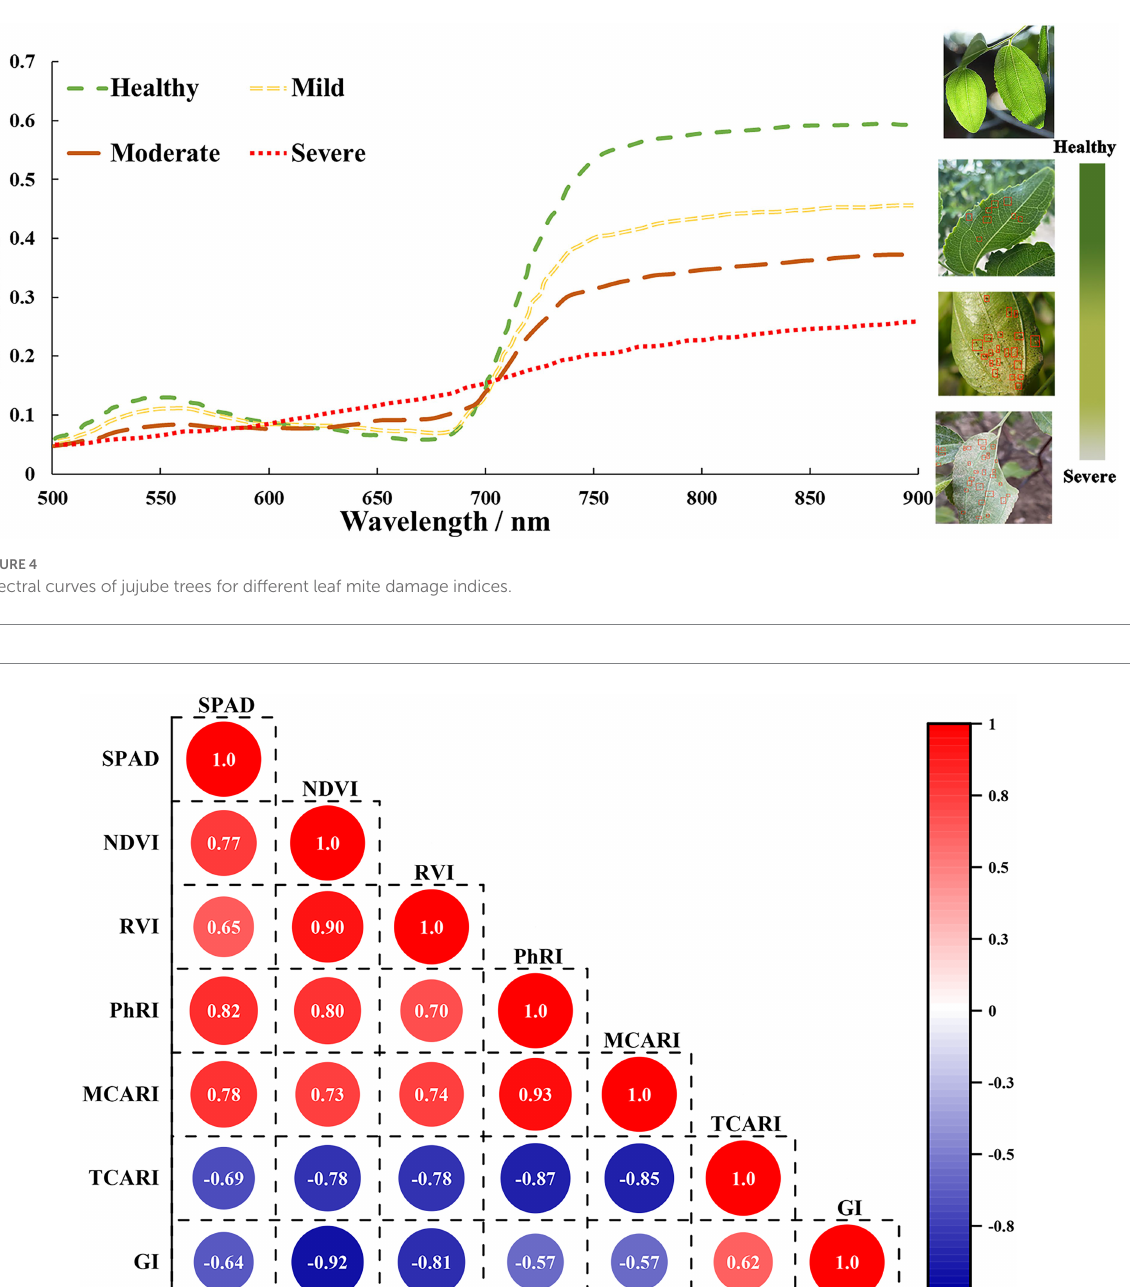
FIGURE 5 Correlation analysis between SPAD and vegetation